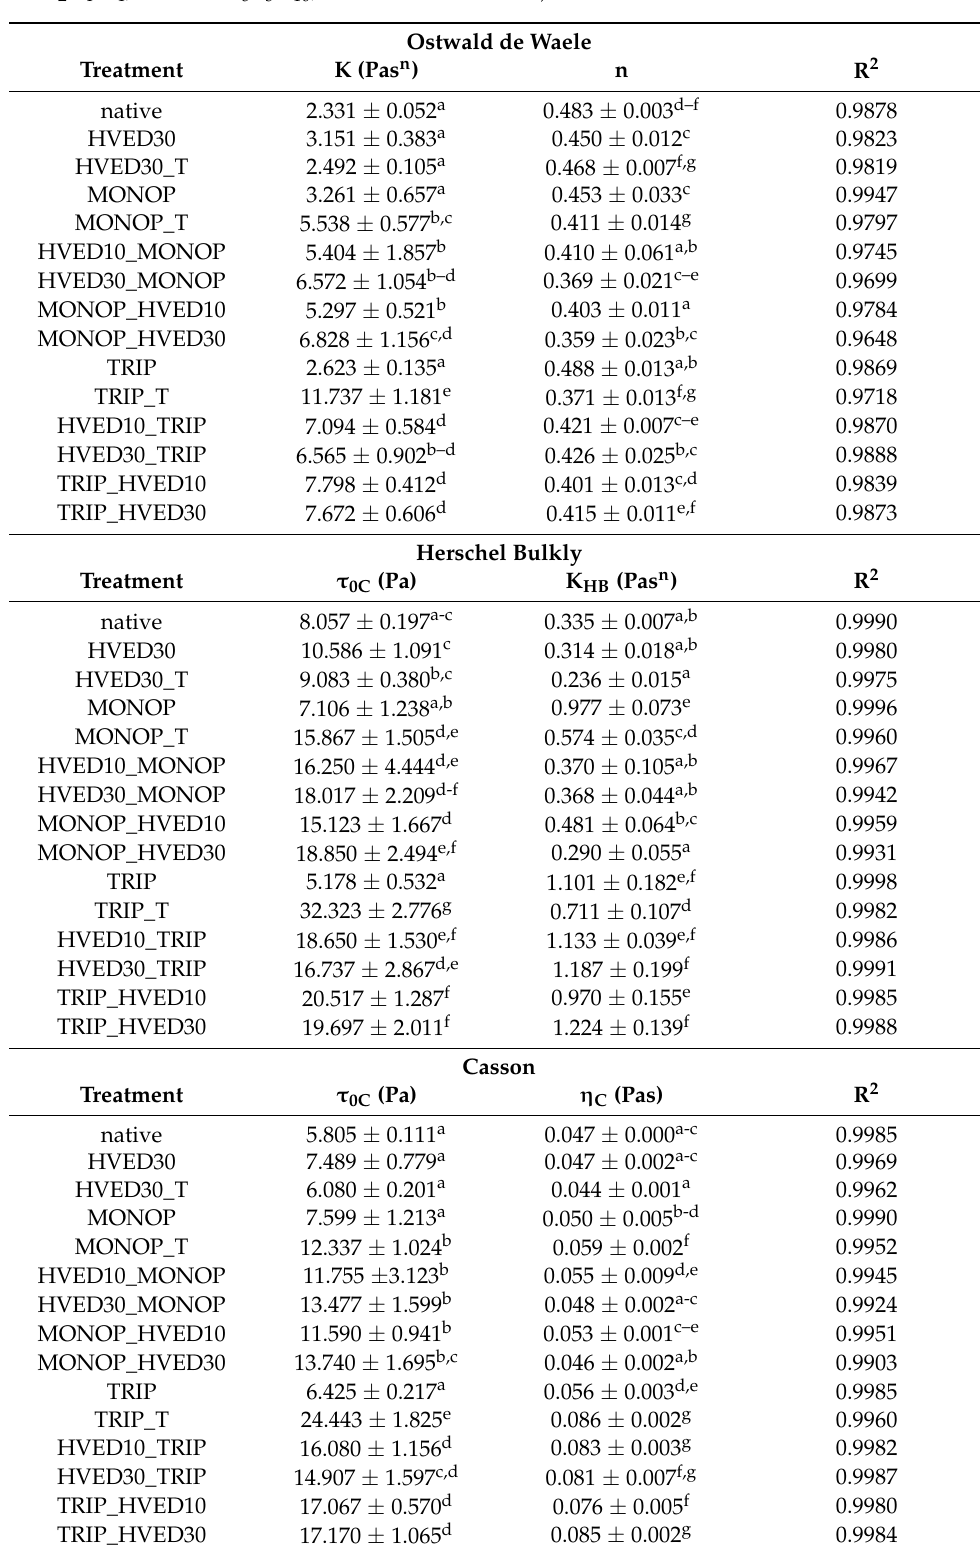
Table 3. Rheological properties of native and modified maize starches described with different models (HVED10 = 10 min treatment with HVED; HVED30 = 30 min treatment with HVED; MONOP = Na 2 H P O 4 ; TRIP = Na 5 P 3 O 10 ; T = thermal treatment).